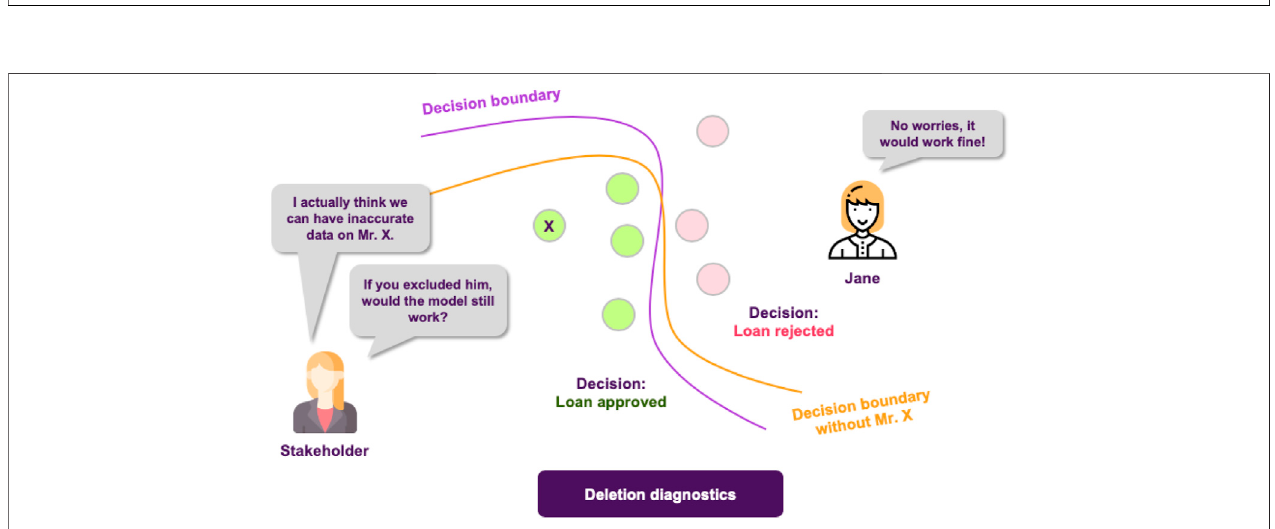
FIGURE 10 | The quality of a ML model is vastly affected by the quality of the data it is trained on. Finding in fl uential points that can, for example, alter the decision boundary or encourage the model to take a certain decision, contributes in having a more complete picture of the model ’ s